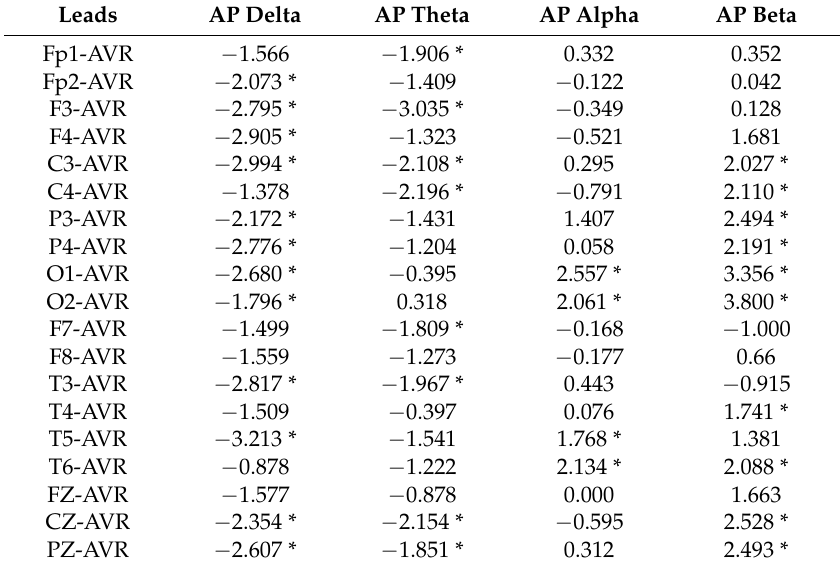
Table 1. Acute effect of dark chocolate intake, T values obtained by comparing the basal values of the Delta, Theta, Alpha and Beta Absolute Power (AP) against the values obtained after the dark chocolate